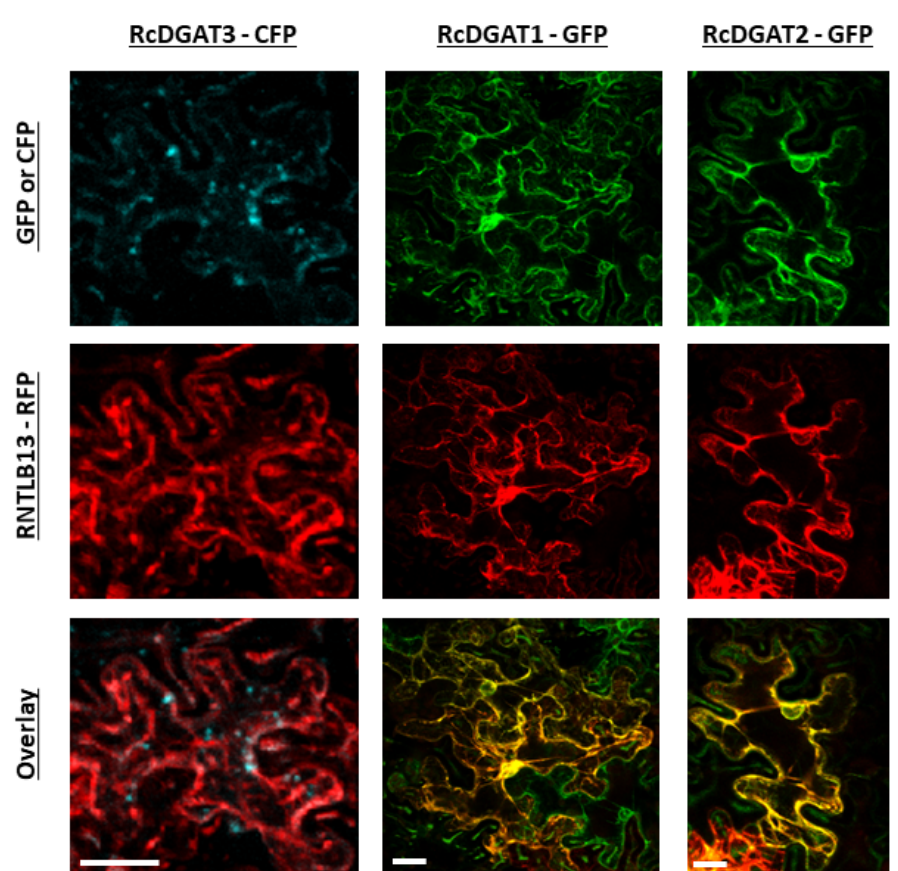
Figure 3 – Transient expression of castor bean DGATs in Nicotiana benthamiana leaves. N. benthamiana leaves were co-infiltrated with Agrobacterium tumefaciens carrying the DGATs CDS translationally fused with CFP, or GFP and with Agrobacterium tumefaciens carrying the RTNLB13 (ER marker) CDS translationally fused with RFP. The first row displays the CFP (blue), or GFP (green) fluorescence; the second row displays the fluorescence of RTNLB13-RFP (red); and the last row shows the overlay of both images. Scale bars = 20 µm.